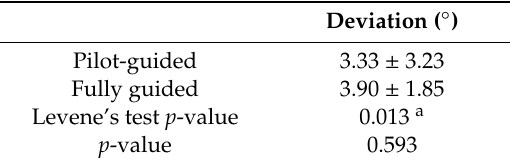
Table 4. Deviations of angle (mean ± S.D.).